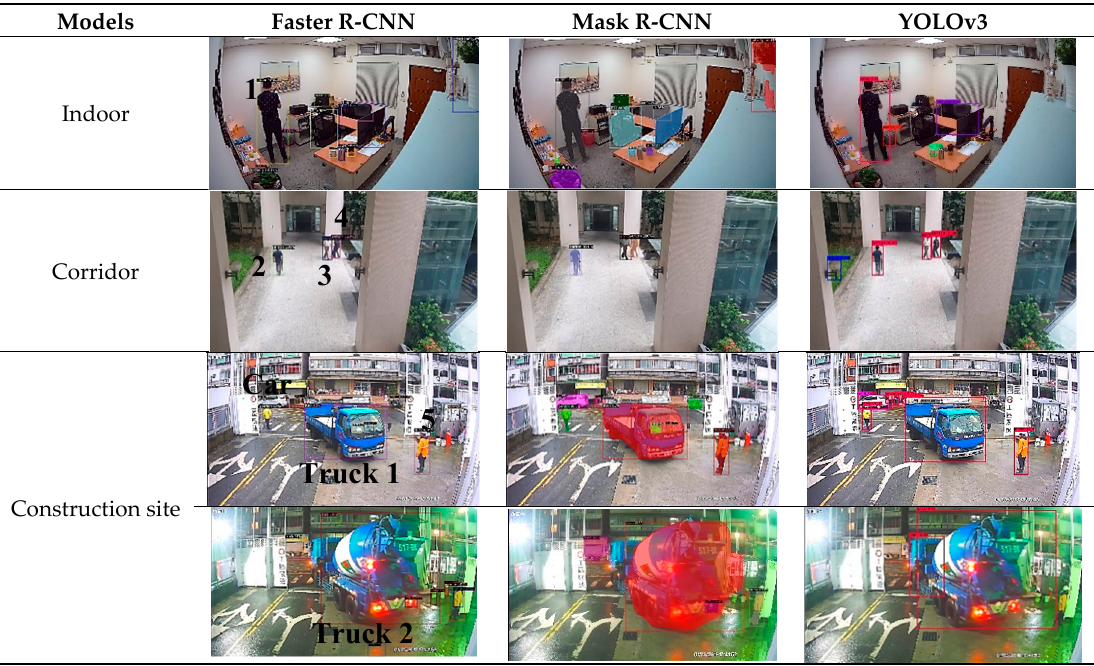
Figure 12. Image dataset for performance evaluation.